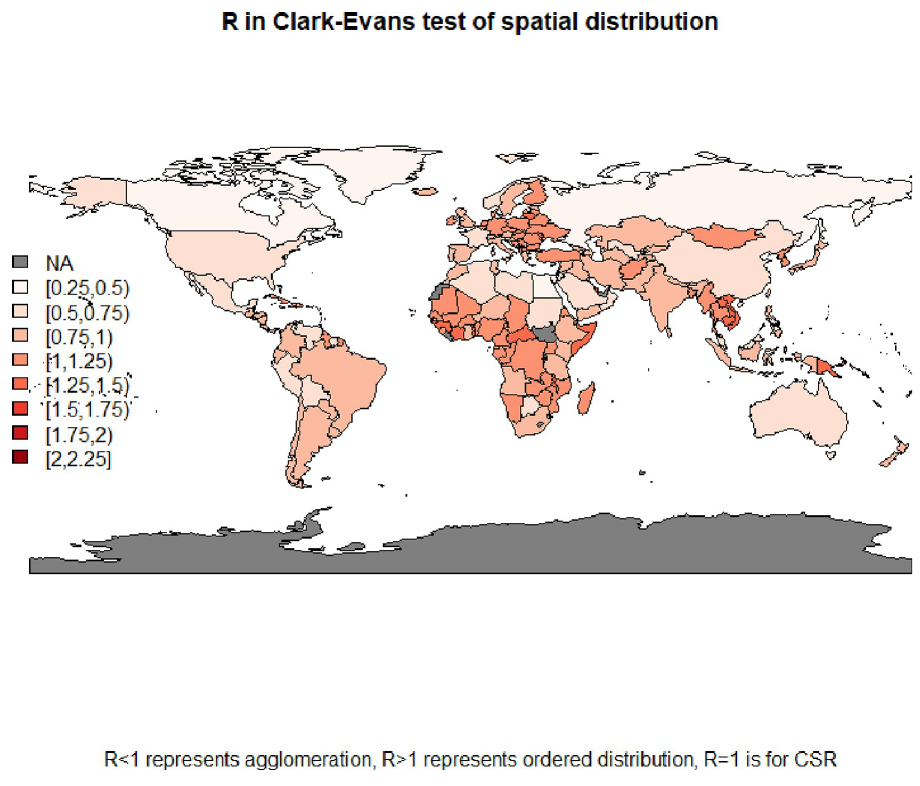
Fig 3. Map of R-value from Clark-Evans test. Source: Own study with the use of spatstat::, maps::, rworldmap:: R packages. significantly. Cristelli et al. (2012) [10] also confirm that Zipf holds conditionally in selected subsamples only. Countries with Zipf-like population distribution are diversified: the number of cities varies from 27 to 985, the coefficient of variation of city size within the country is between 0.84 and 7.4, Clark-Evans R is between 0.42 and 1.25, and countries are on all continents.